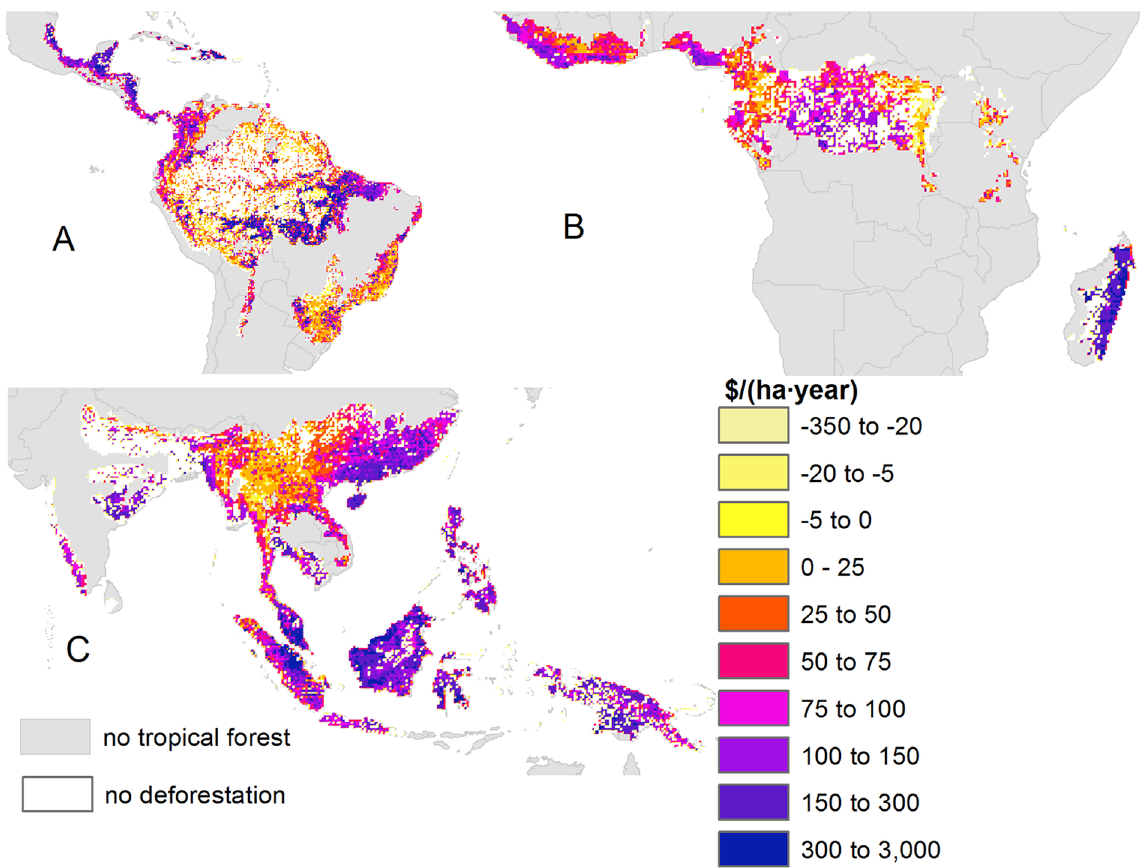
Fig 2. The economic implications of deforestation in tropical forests from 2000 to 2012. Comparisonof carbonemissions assessedat market prices plus loss of ecosystem services (ES) values minus gains of agriculturalrents. Replacement of land by those crops in the tropical forest biome already present in the country is assumed (Scenario A). The medianvalues of the simulations are shown. Maps corresponding to the 2.5th and 97.5th percentiles of the uncertainty distribution of outcomes are available in S3 and S4